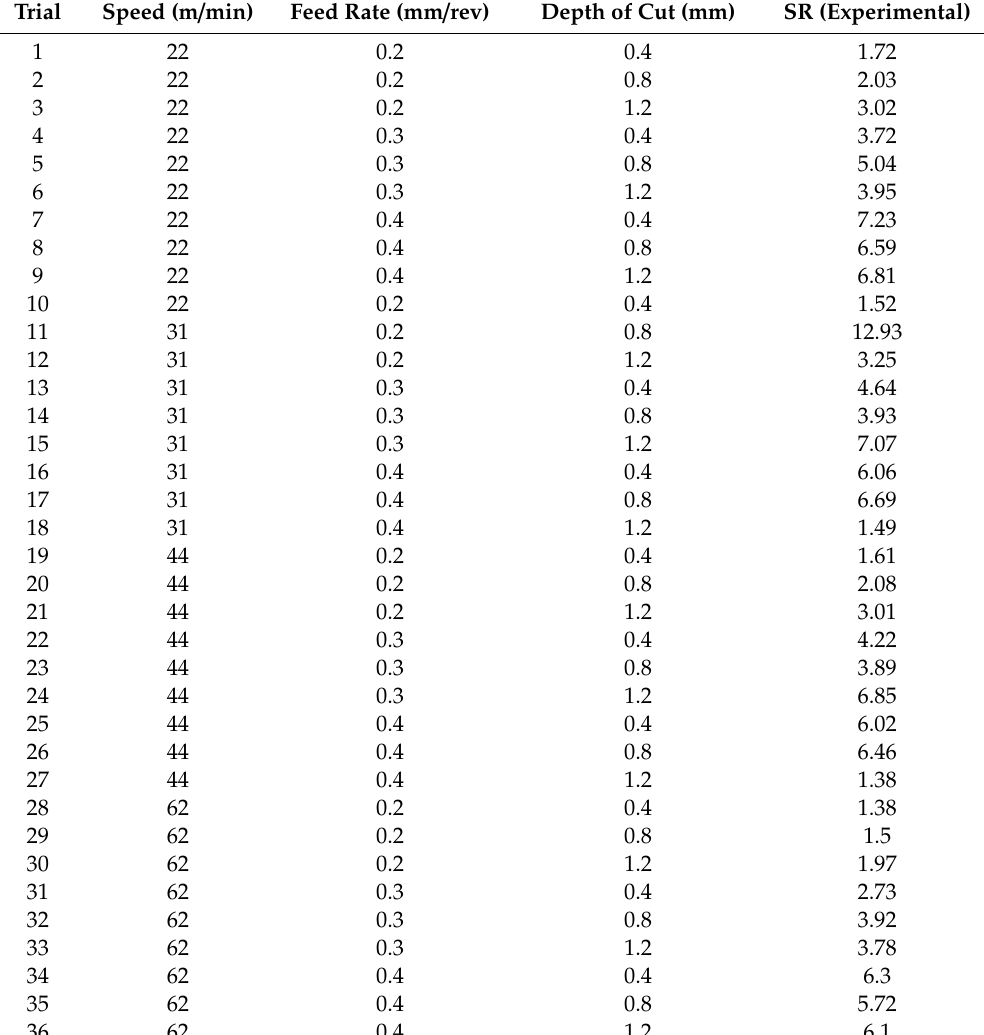
Table 2. Cryogenic turning process experimental data [40].